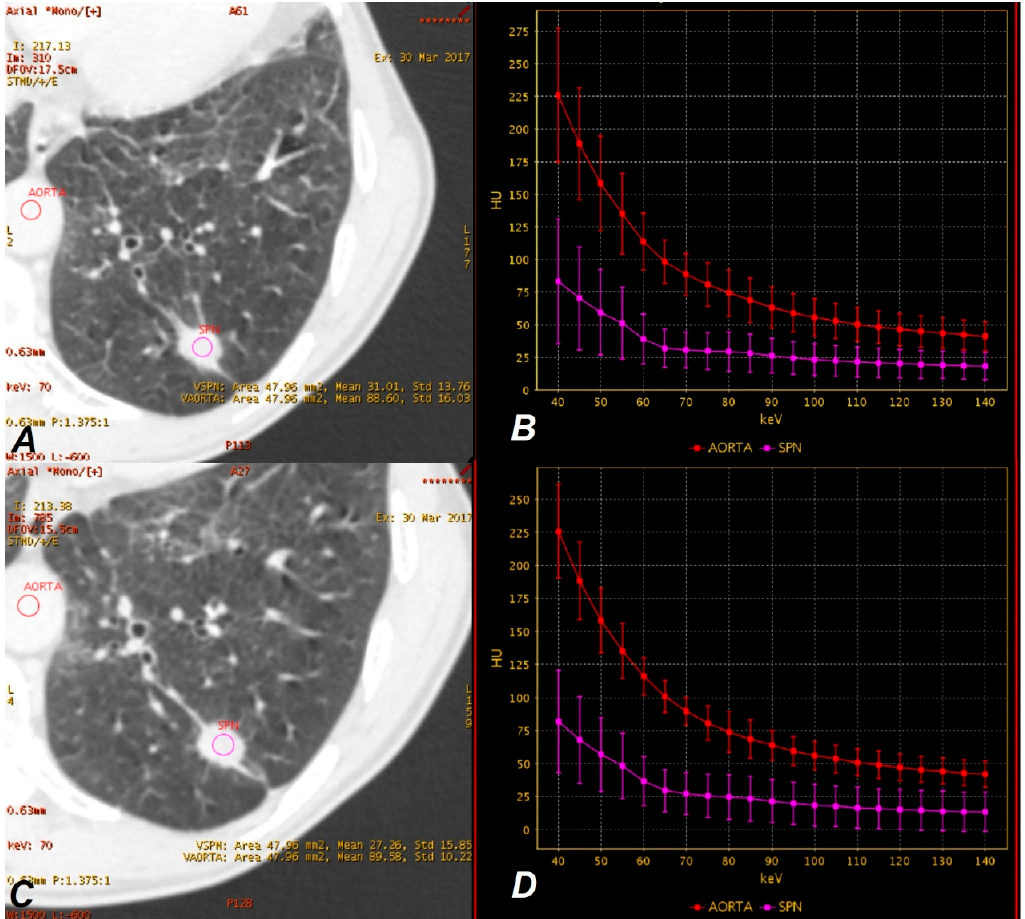
Figure 3. A 60-year-old man with tuberculoma in AP ( A , B ) and VP ( C , D ). Monochromatic 70 keV SS DECT images show an attenuating SPN on the left lung (purple ROI) ( A , C ). Graphs show DECT spectral attenuation curves for the enhancing mass SPN (purple) and descending aorta (red) ( B , D ). The smaller slope of the spectral curve and lowering of the position than in Figure 2b,d is due to the lower accumulation of iodine in the tumor. Attenuation SPN mean: (AP) = 31.01 HU, (VP) = 27.26 HU. The value of p < 0.05 was considered statistically